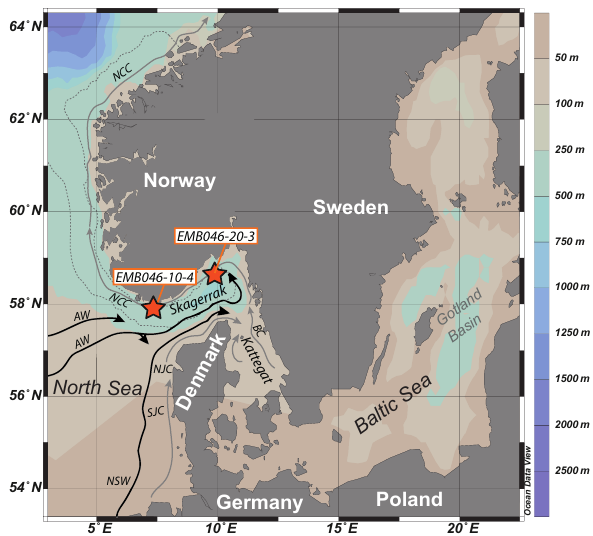
Figure 1. Map of core locations (stars) in the Skagerrak in the north-eastern North Sea (modified from Polovodova Asteman et al., 2018). The Norwegian Trench is outlined by a thin grey dotted curve along the coast of Norway. Major current systems and water masses in the Skagerrak are indicated by arrows: the Baltic Current (BC), Northern Jutland Current (NJC), Southern Jutland Current (SJC), Norwegian Coastal Current (NCC), North Sea Water (NSW) and Atlantic Water (AW). The light grey arrows show surface water and the black arrows show subsurface